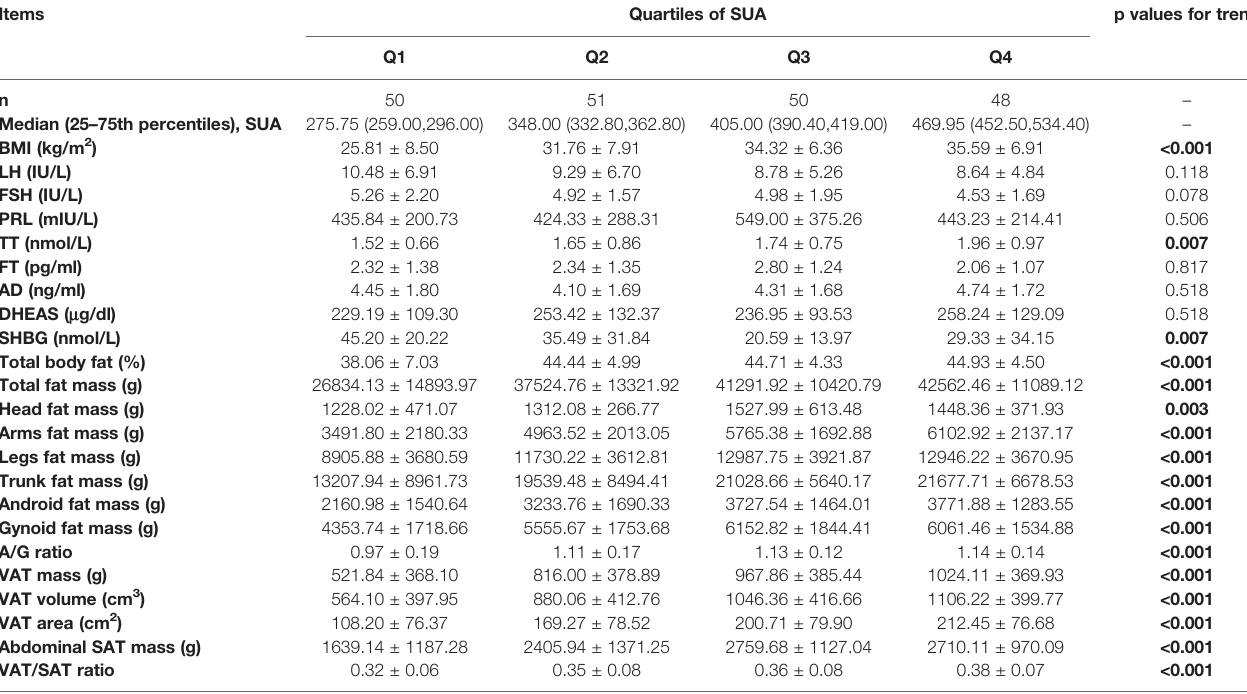
TABLE 3 | Reproductive hormones and body fat distribution characteristics of the patients with PCOS across quartiles of serum uric acid. Items Quartiles of SUA p values for